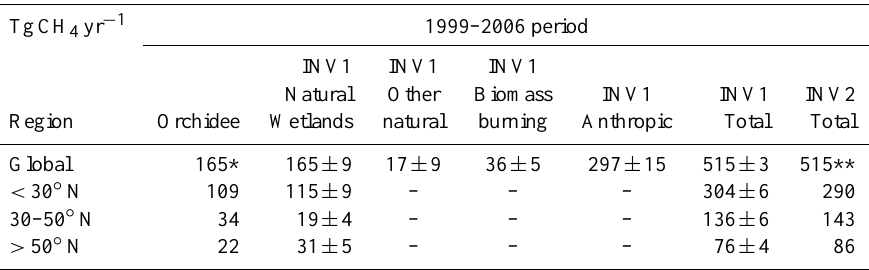
Table 2. Methane surface fluxes averaged for the 1999–2006 period, in TgCH 4 yr − 1 . From left to right, CH 4 fluxes are given: for natural wetlands from ORCHIDEE model, for four categories of emissions inferred by INV1 (wetlands, other natural, biomass burning, total), and for the total emissions inferred by INV2. For INV1, values are the mean of the 11 inversion performed. From top to bottom: global, < 30 ◦ N, 30–50 ◦ N, > 50 ◦ N. Total fluxes are the sum of surface emissions and soil uptake. The uncertainty assigned to INV1 is the residual uncertainty returned by the inversion procedure (1-sigma). For INV1, regional fluxes are not shown for sources other than wetlands, as we do not discuss their anomalies (Table 3), which are generally very small.